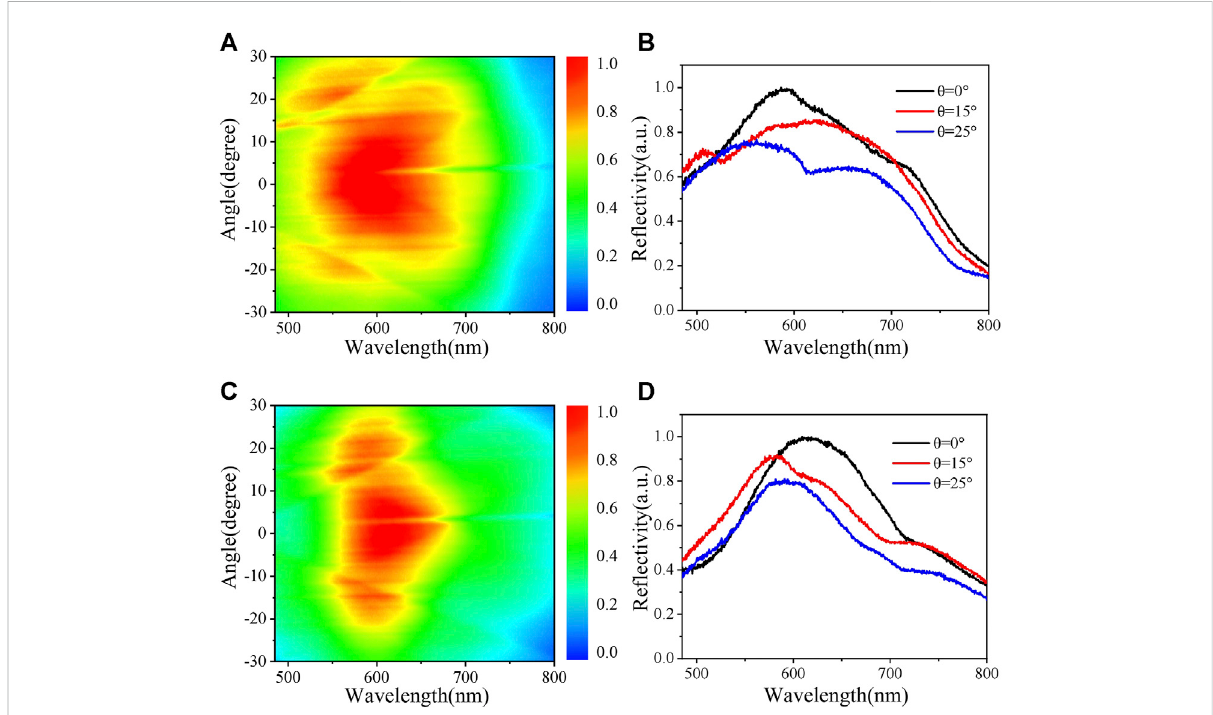
FIGURE 3 Experimentally measured angle-resolved re fl ection spectra of trimer or pentamer Au nano fi nger arrays with lattice constant of 670 nm. (A) Re fl ection spectra of trimer Au nano fi nger arrays for the incidence angle varied from -30 ° to 30 ° . (B) Experimental re fl ection spectra of trimer Au nano fi nger arrays at the incidence angle of 0 ° , 15 ° and 25 ° , as selected from (A) . (C and D) Corresponding data for pentamer Au nano fi nger